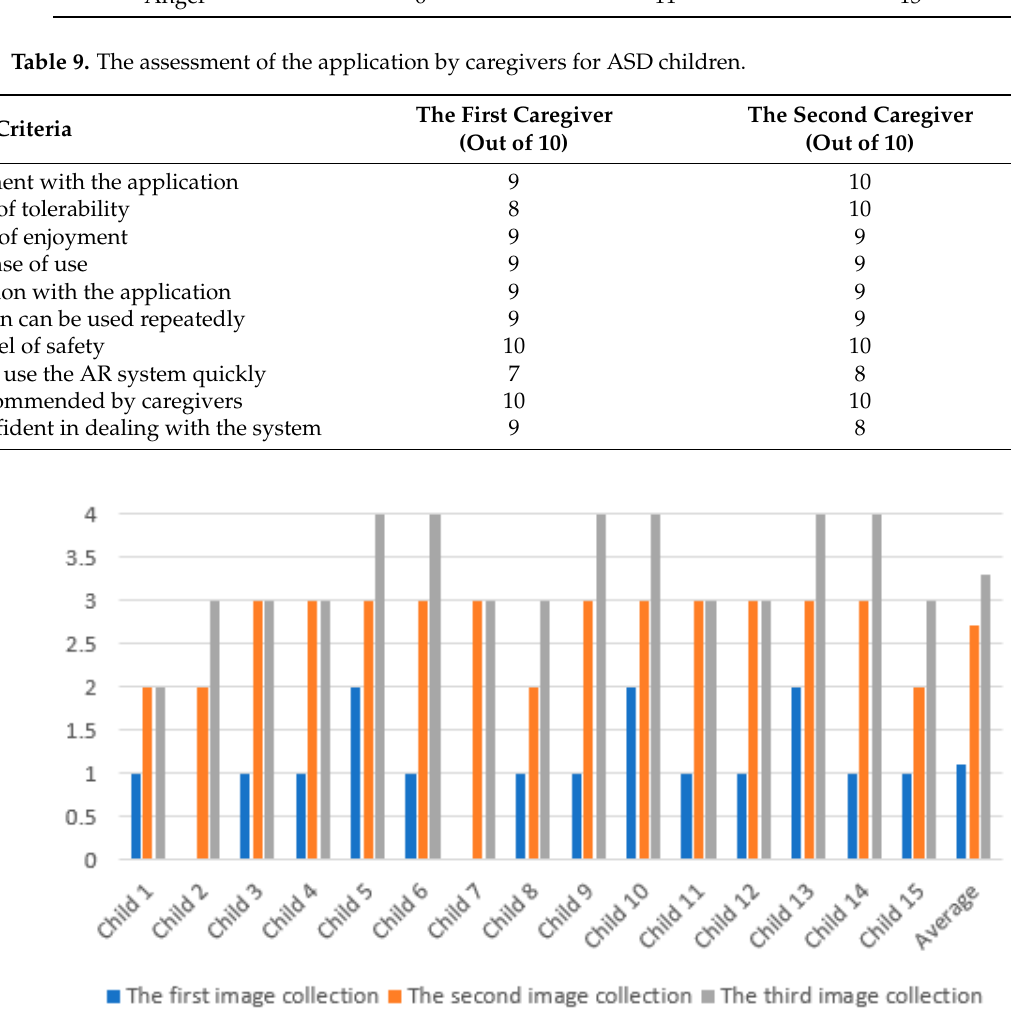
Figure 9. Autistic children’s interaction with the three face collections on the first day. Table 7. The caregiver reports on child interaction with the three face collections with correct answers (0–6) in the second day for the ASD children.